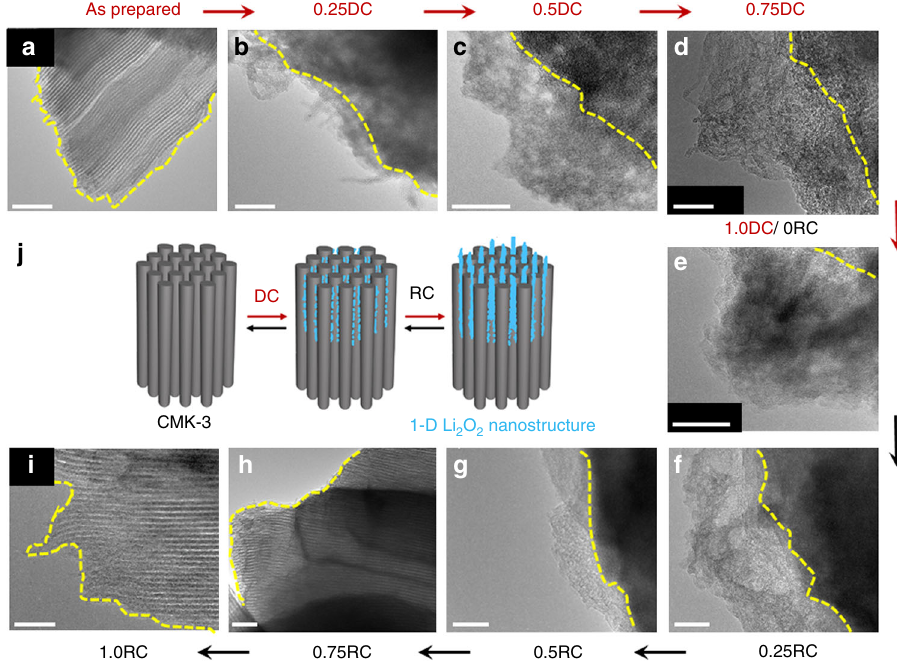
Fig. 2 Transmission electron microscopy (TEM) images. a As-prepared, b – e discharging, and f – i recharging CMK-3 surfaces. The scale bars are 50 nm. The top label of the image denotes the depth of DC or RC, denoted by Q / Q total at a fi xed Q total of 1.0 mAh and the current rate of 50 mA g – 1 carbon . The yellow dashed lines indicate the surface of CMK-3. j Schematic illustration of initial growth of Li 2 O 2 , blue poducts, from CMK-3 electrode. From over 0.5DC, the one-dimensional structure and ultrathin Li 2 O 2 grow upward by loosely entangling with one another, which display fl ake-like shapes (see SEM images in Supplementary Figure